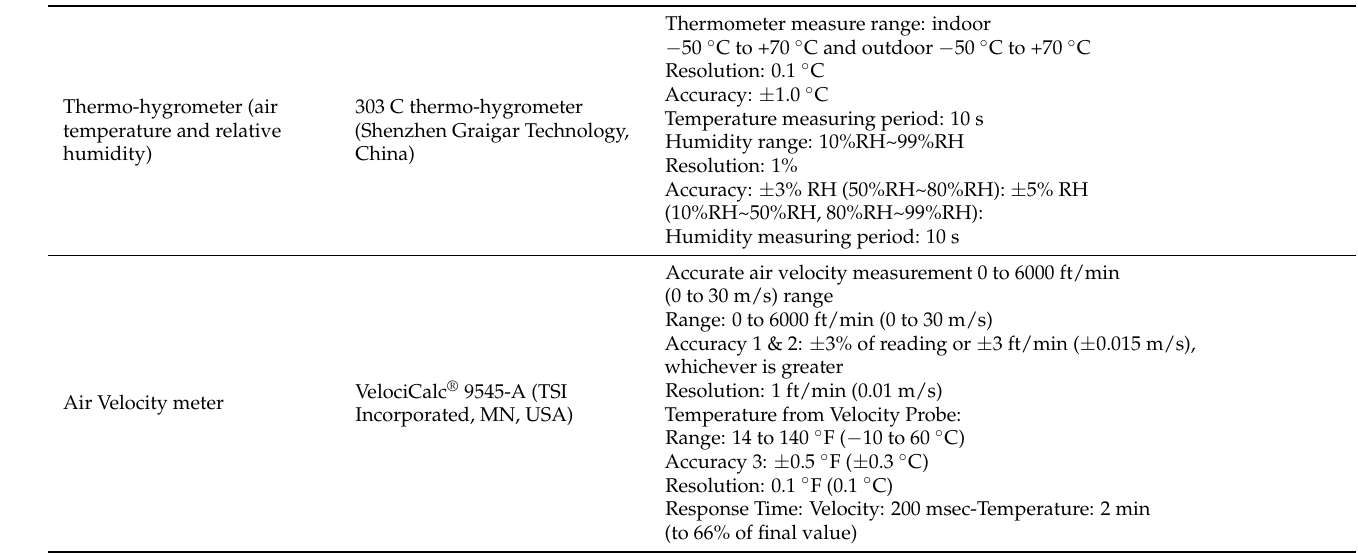
Table A1. Technical details of the measuring instruments.